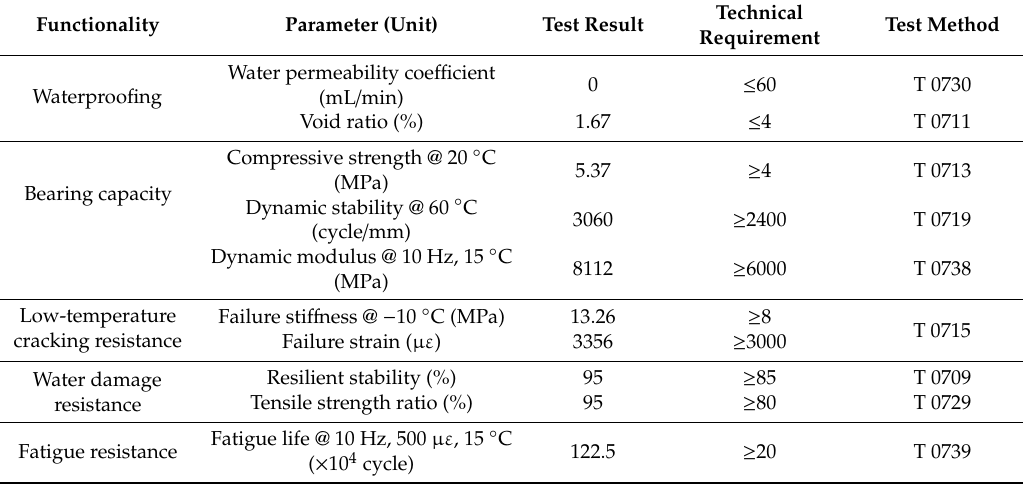
Figure 3. Some test samples and procedures: ( a ) infiltration test; ( b ) wheel tracking test; ( c ) indirect tensile test; ( d ) fatigue test; ( e ) low temperature bending beam test; and ( f ) dynamic modulus test. Table 3. Laboratory test results and technical requirements of the designed asphalt concrete.